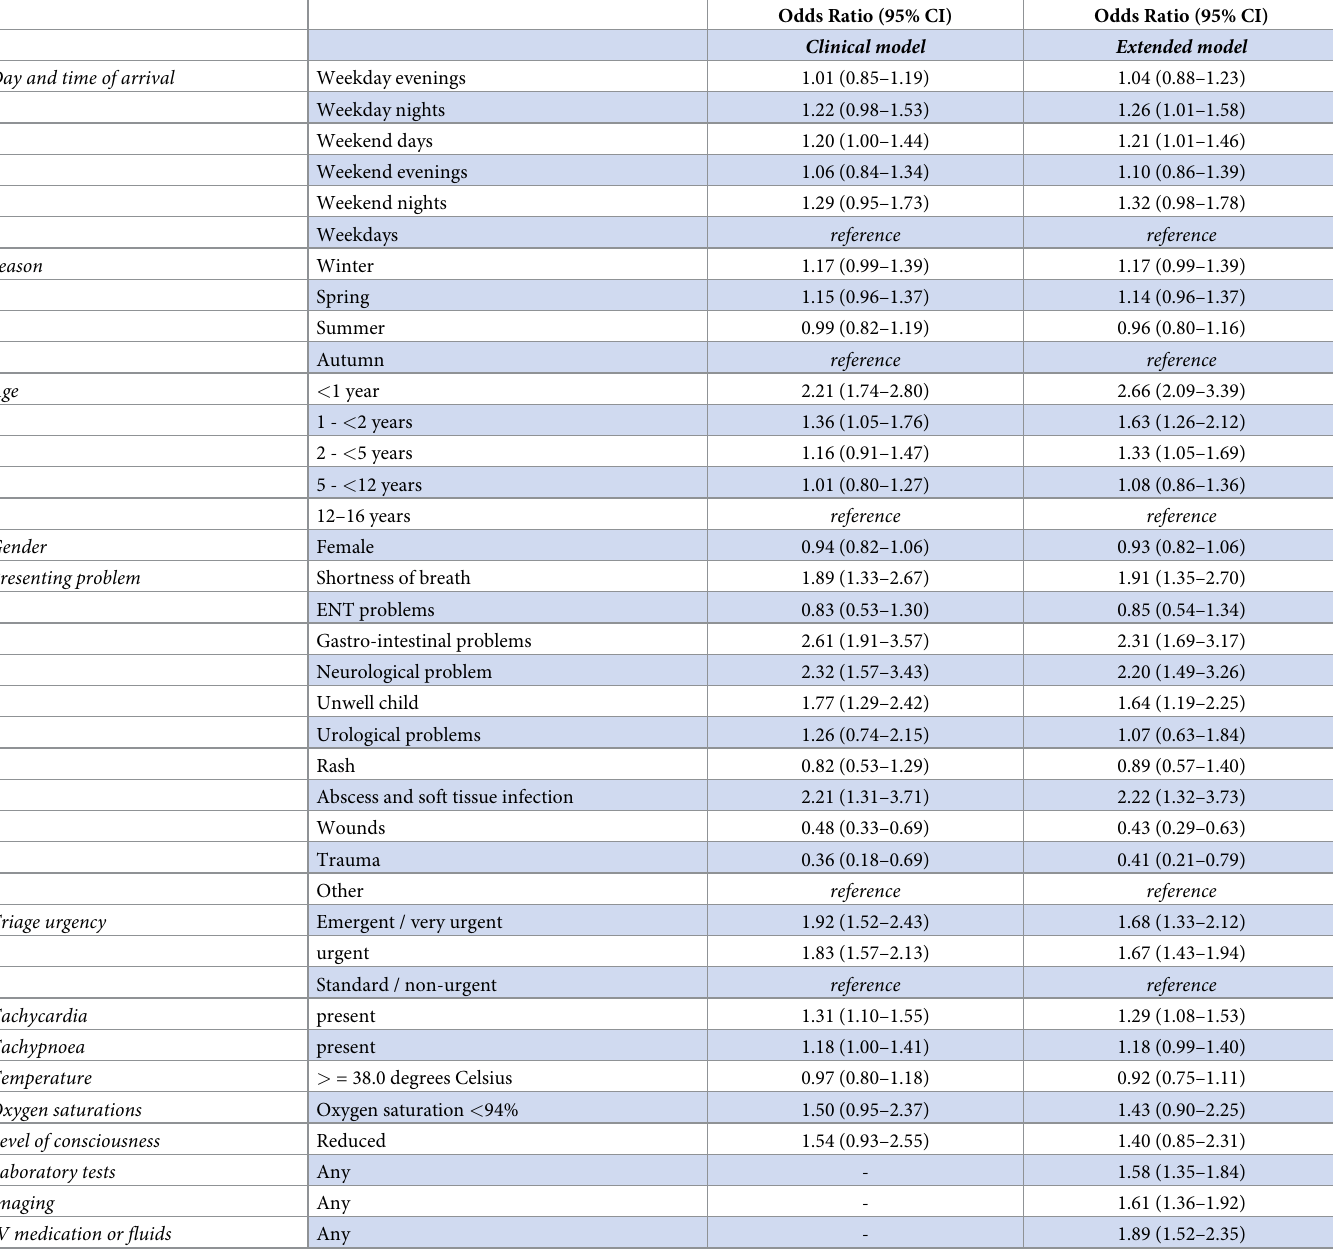
Table 3. Clinical prediction models with clinical characteristics of the index visit to predict the presence of a serious illness at the time of